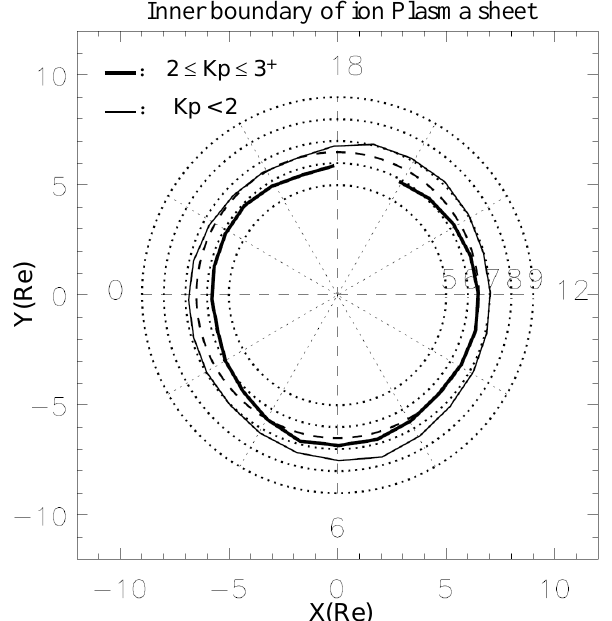
Fig. 3. The mean radial distance of IBIPS for quiet times (Kp < 2) and active times (2 ≤ Kp ≤ 3 + )